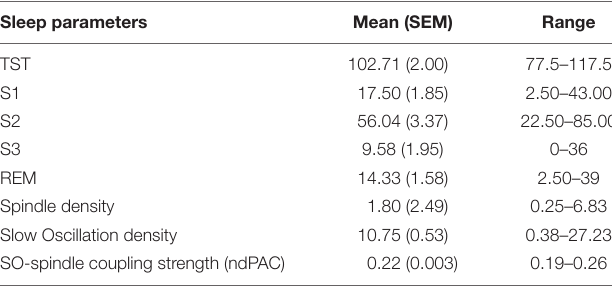
TABLE 2 | Time spent asleep, sleep spindle, slow oscillation, and spindle\SO coupling strength as means, standard errors, and ranges. Sleep